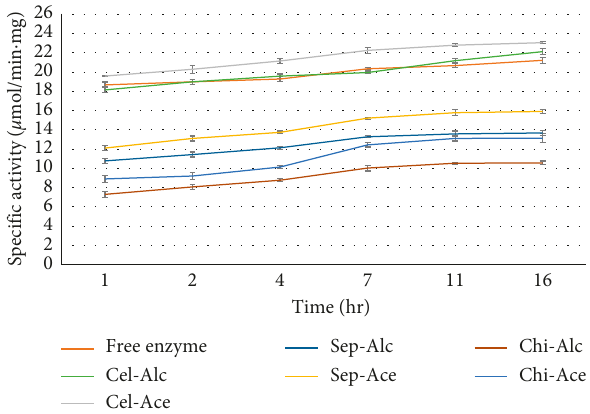
1mg/mL (pH 7.0 (cid:31)